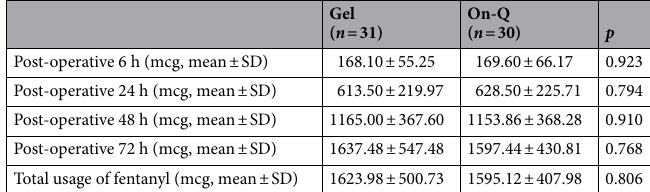
Table 2. Amount of fentanyl consumption. hrs hours, SD standard